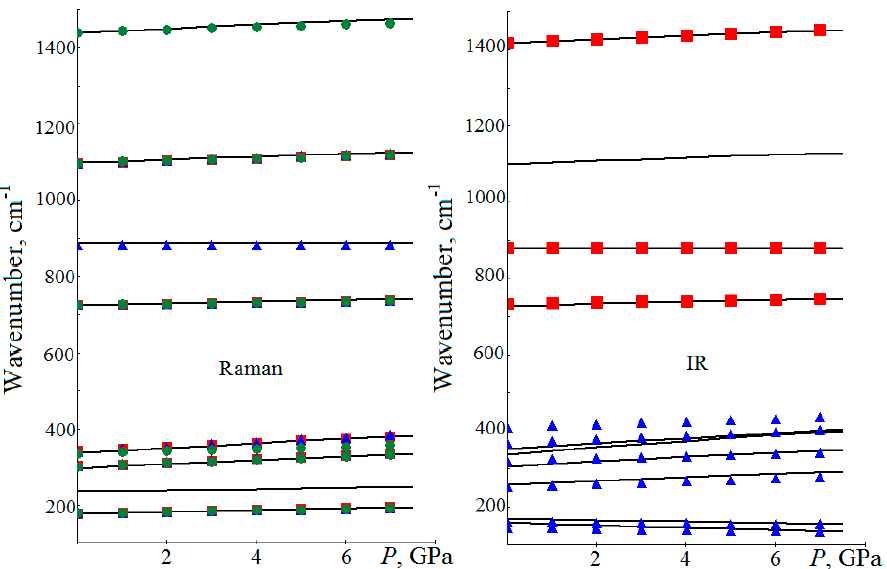
Figure 4. Calculated dependence of lattice and intramolecular vibrational mode wavenumbers (solid lines) of CaMg(CO 3 ) 2 on the P pressure, active in the Raman spectrum (left: squares illustrate experimental data from [14], triangles—from [22], circles—from [20]) and the infrared spectrum (right: squares from [14], triangles from [8]).